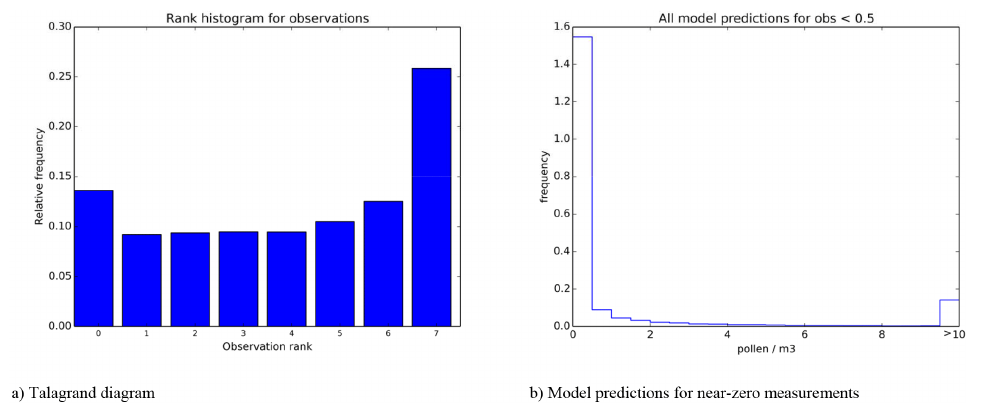
Figure 10. Ensemble characteristics: (a) Talagrand diagram for the constructed ensemble (daily concentration statistics) and (b) histogram of model predictions when observations were below the detection limit 0.5 pollenm − 3